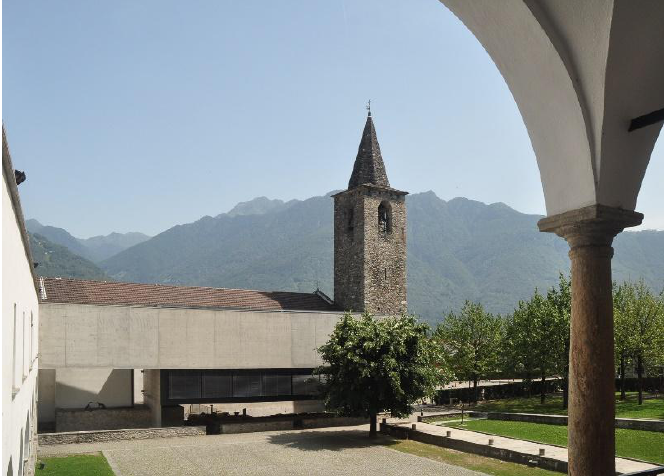
Figure 2. Ex-Augustinian convent converted into a primary school—the symbol of Monte Carasso’s urban transformation. Source: Author.